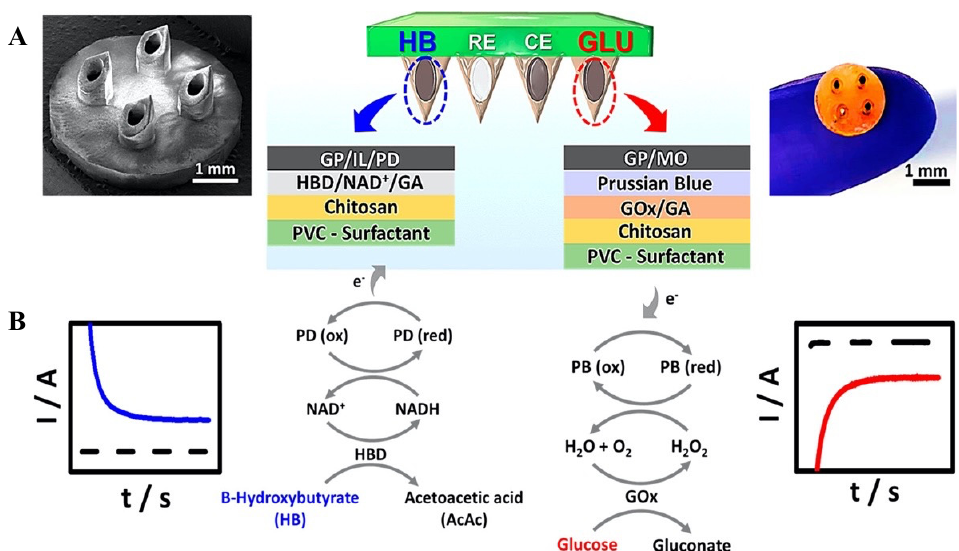
Figure 2. ( A ) The schematic representation of dual-marker β− hydroxybutyrate/glucose − sensing on a MN biosensor platform. ( B ) A schematic illustration of the dual-analyte amperometric detection mechanism on multilayer modified biosensors for β− hydroxybutyrate (marker) ( left ) and glucose ( right ). Reprinted with permission from ref. [157]. Copyright 2020, ACS Publications.